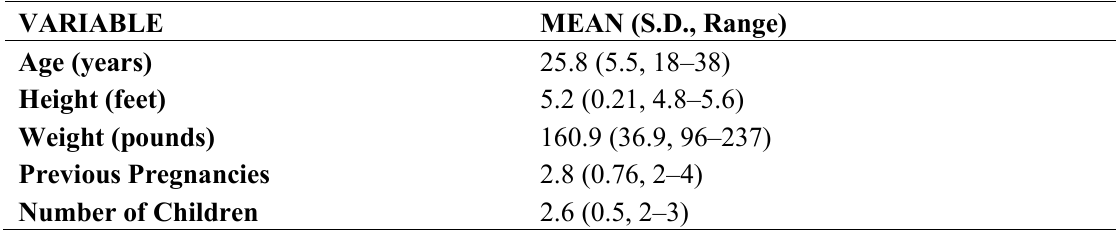
Table 1. Sociodemographic attributes of women participating in the study (N =